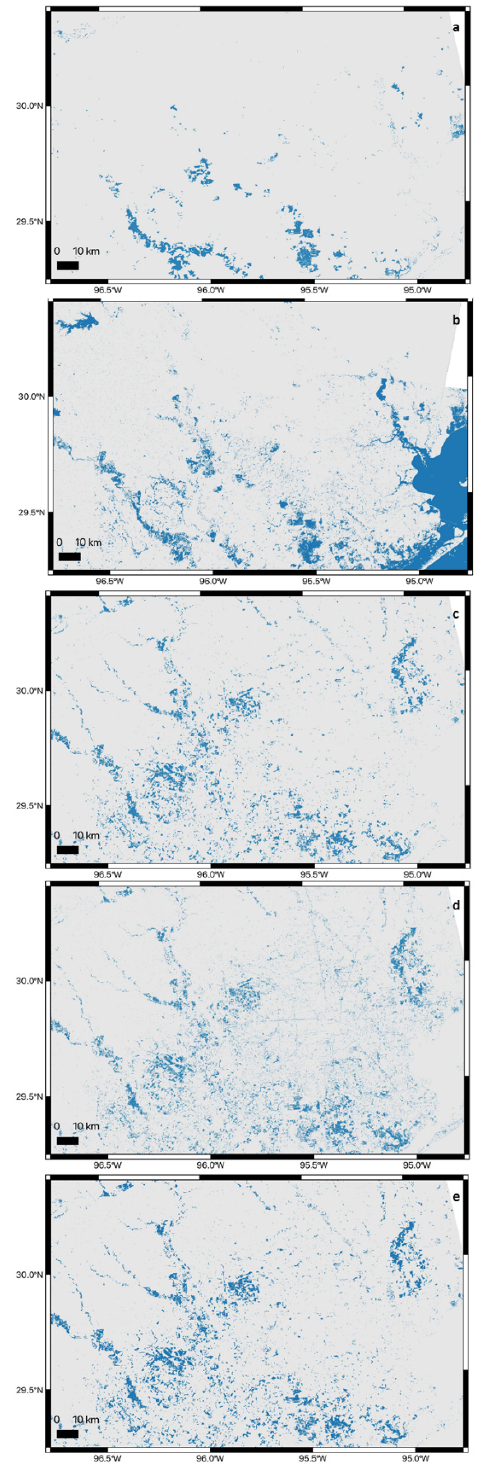
Figure 10. ( a ) Water pixels identified by MODIS data, courtesy of the DFO [41] 250 m pixel spacing; ( b ) water pixels identified from NDWI analysis of Sentinel-2 data, 10 m pixel spacing; ( c ) water pixels identified by the DeepLabv3+ analysis of SAR GRD data, 29 August 2017, 10 m pixel spacing; ( d ) water pixels identified from thresholding analysis of the same SAR GRD data, 10 m pixel spacing; and ( e ) water pixels identified by the ML analysis of the RGB classification of the SAR GRD data, 10 m pixel spacing. The GWM is removed from all results except the NDWI ( b ). Water pixels are shown in blue in all subfigures.